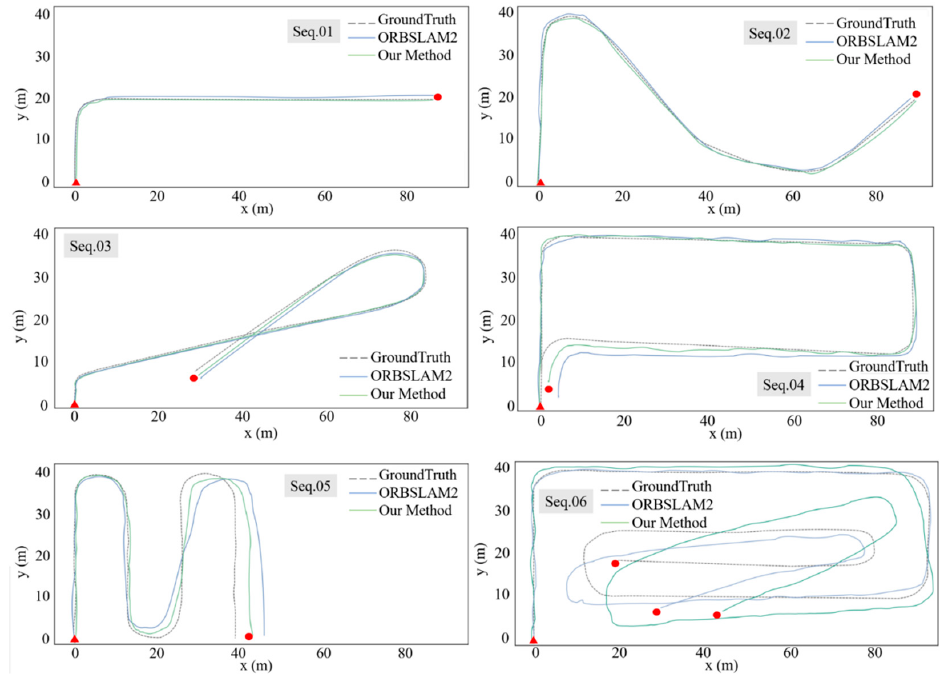
Figure 9. Trajectories for our method, ORB-SLAM2, and ground truth on Seqs. 01 to 06; triangles and circles highlight respectively the start and end of the trajectories.